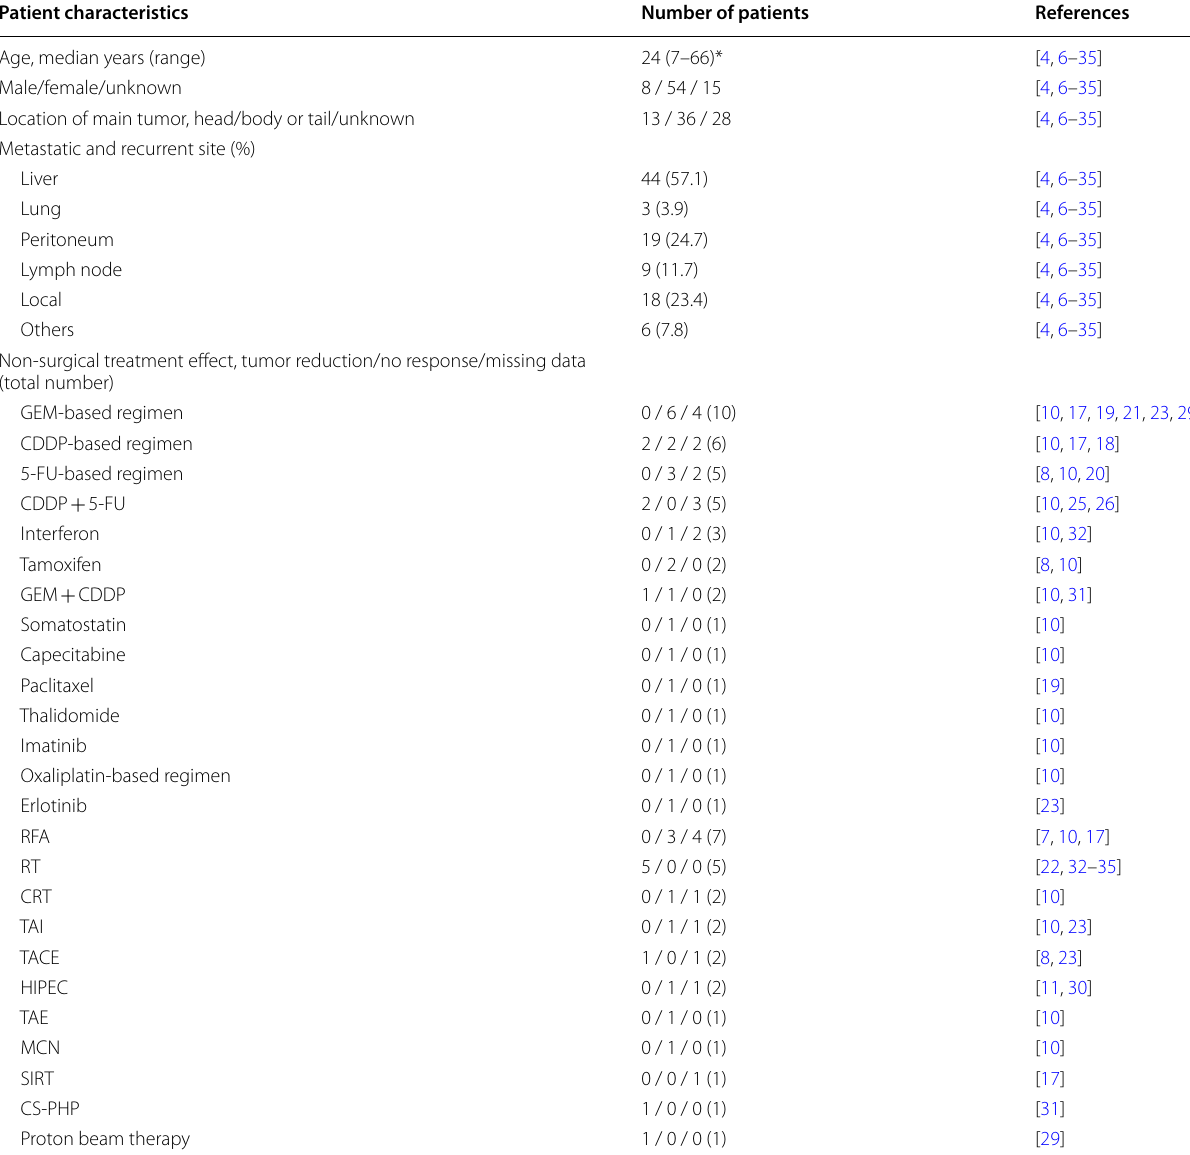
Table 1 Characteristics of 77 SPN patients with malignant behavior (distant metastasis, recurrence and/or invasion) in the